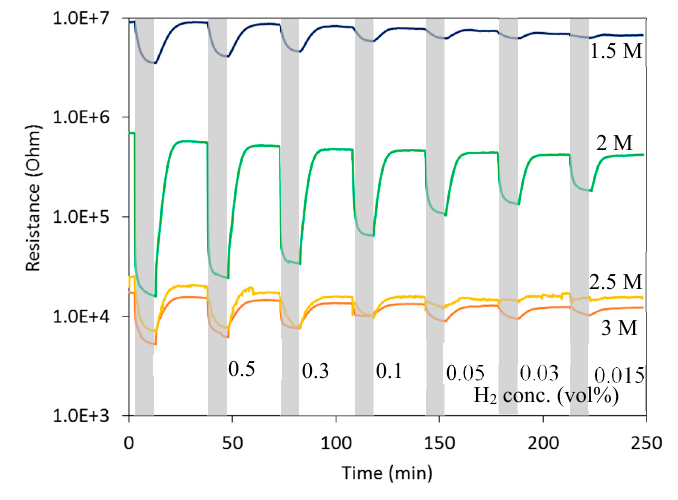
Figure 3. Resistance vs. time of 2D WO 3 nano-structures prepared by anodization with different HNO 3 concentrations subjected to various H 2 pulses at 350 °C.